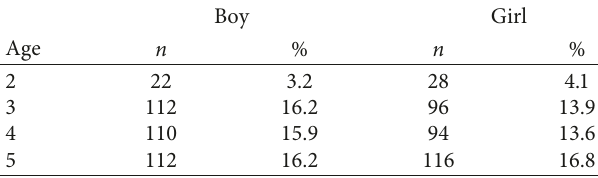
Table 1: The percentage of the participated children by age and